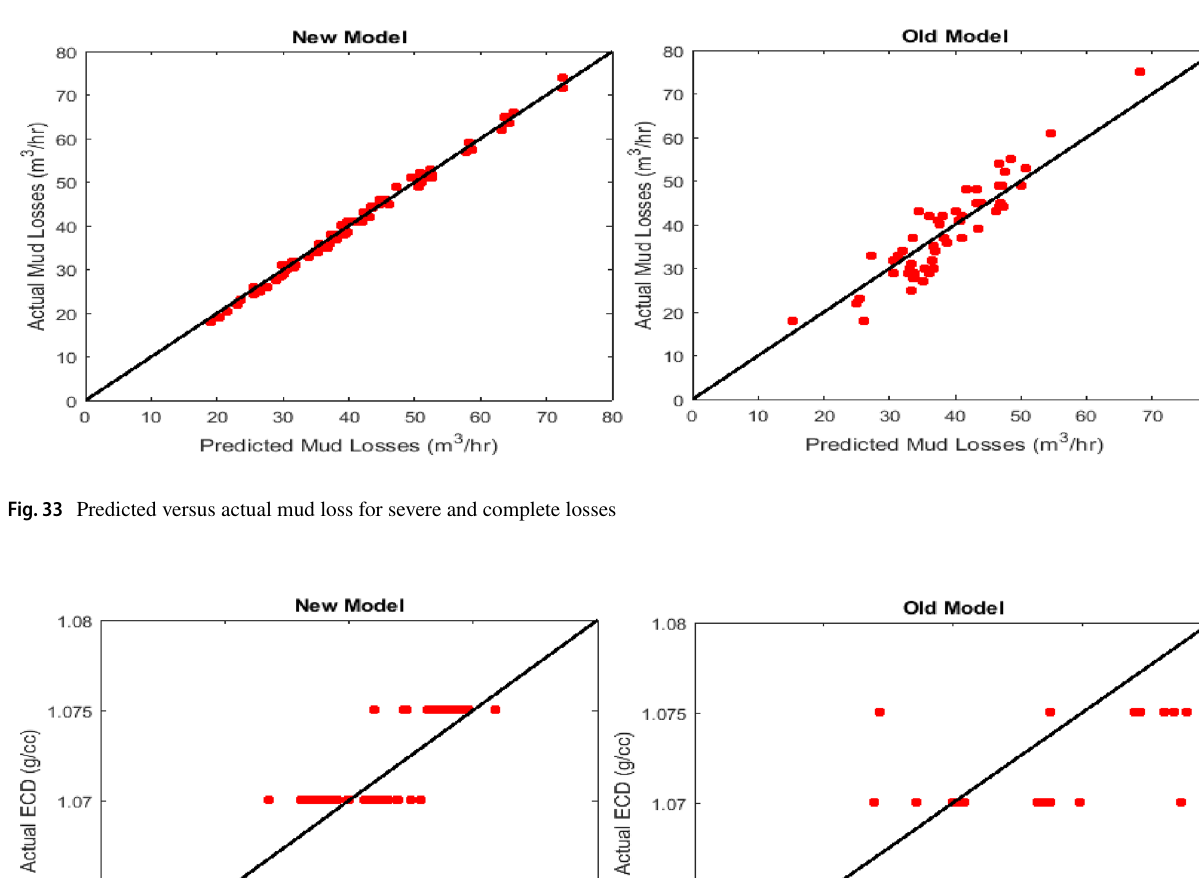
Fig. 32 Predicted versus actual mud loss for partial losses